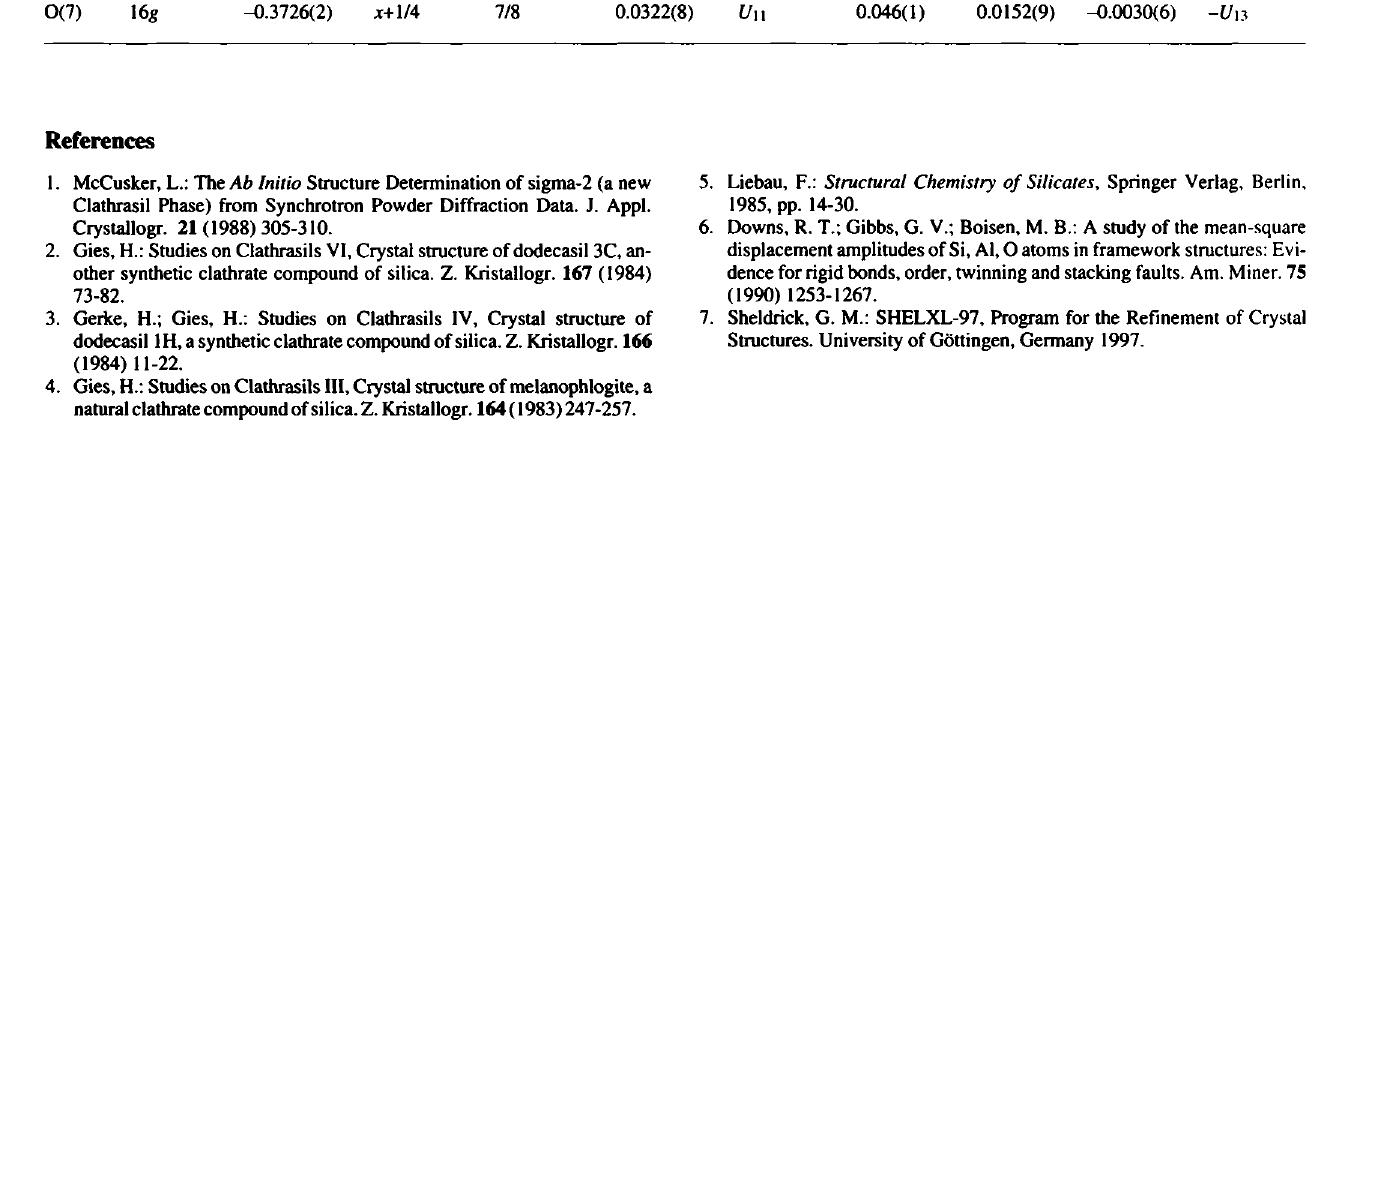
Table 3. Atomic coordinates and displacement parameters (in A 2